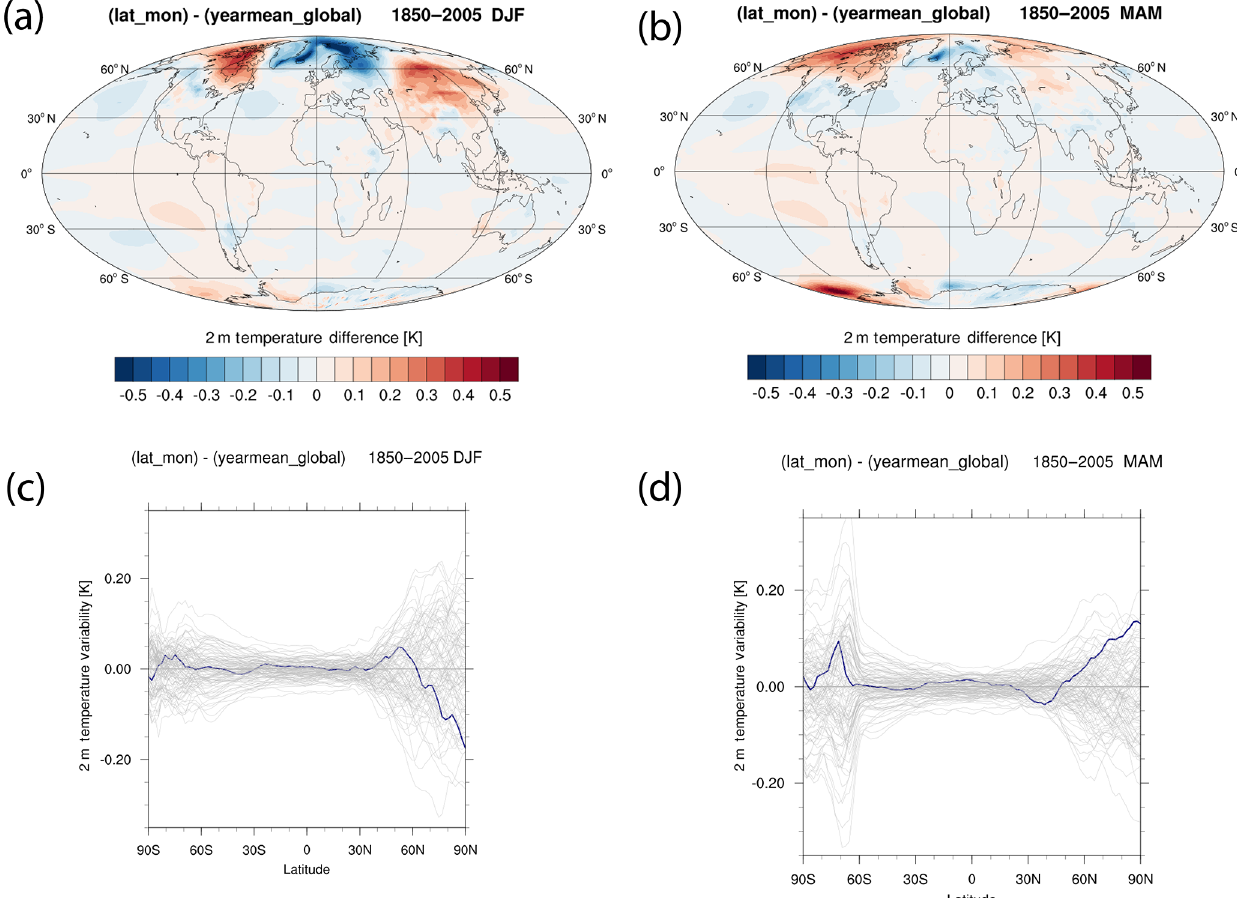
Figure 12. Warming signal induced by latitudinally and seasonally resolved GHG concentrations (“lat_mon”) compared to an annually and global-mean uniform GHG concentrations (“yearmean_global”) in an Earth system model, namely CESM1.2.2 (Hurrell et al., 2013). We averaged the full historical scenario from 1850 to 2005 across all six ensemble members in each setup (“lat_mon” and “yearmean_global”) and produced the averages for the December–January–February DJF average (a) and the March–April–May averages (b) . The latitudinally averaged warming signals that result from using spatially and temporarily resolved GHG concentrations are shown in (c) and (d) (thick blue lines), here compared against comparable 100 differenced pairs of 930-year-long control run segments (thin grey lines). In the high upper north during the MAM season, the comparison with control run segment differences suggests that these ESM model results show a significant warming at the 5% level, given that only 3 to 5 of the 100 control run differences are